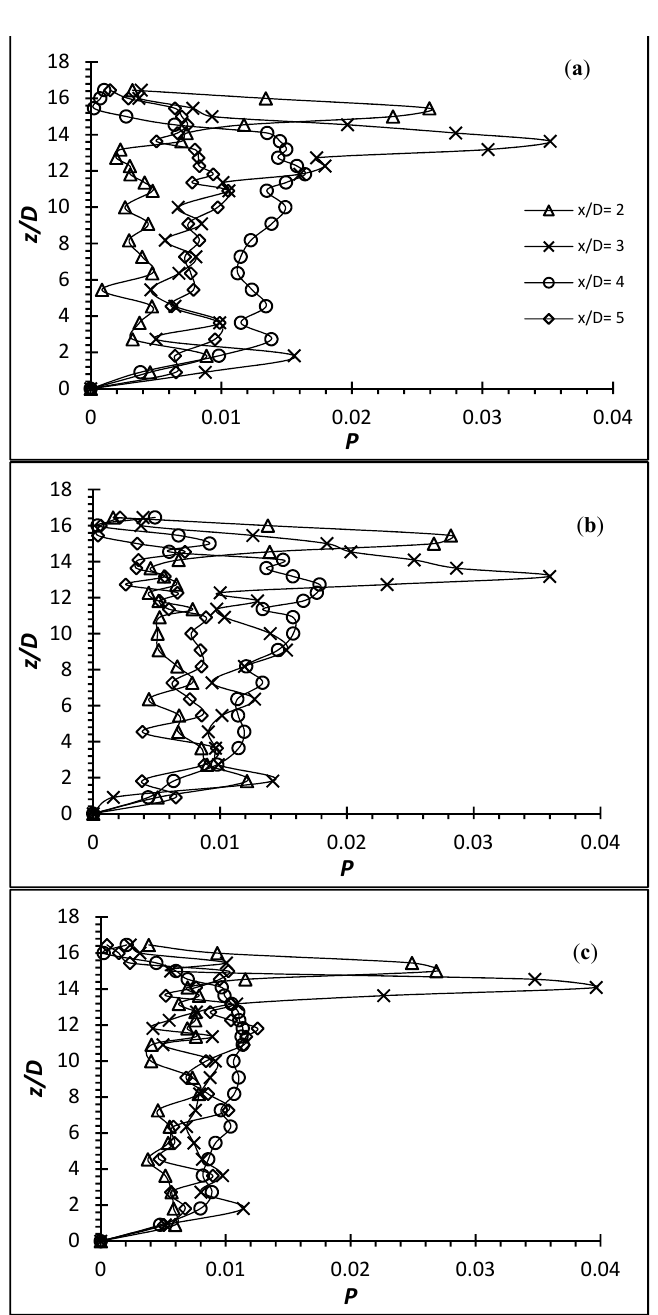
∂ U i for rigid cylinder of AR = 16 at ( a ) Re = 4000; ( b ) Re = 6000; ( c ) u (cid:48) for rigid cylinder of AR = 16 at ( a ) Re = 4000; ( b ) Re = 6000; i j ∂ x j (cid:3105)(cid:3051) (cid:3285)